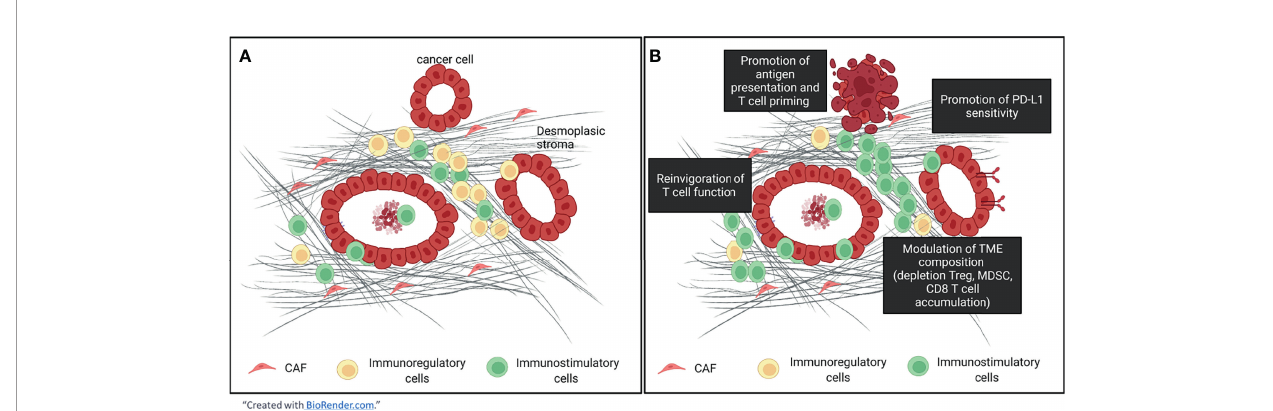
FIGURE 1 | The tumor microenvironment of pancreatic ductal adenocarcinoma and impact of the chemo-immunotherapy. (A) The tumor microenvironment of the pancreas is highly in fi ltrated by immunosuppressive cells (MDSC, Treg, M2 macrophages). (B) Chemotherapy promotes T cells recruitment and their priming which could counterbalance the ratio immunosuppressive / effector cells within the TME while ICP inhibitor reinvigorates exhausted T cells. Moreover, an upregulation of PD-L1 expression has been observed and may increase the sensitivity to PD-(L)1